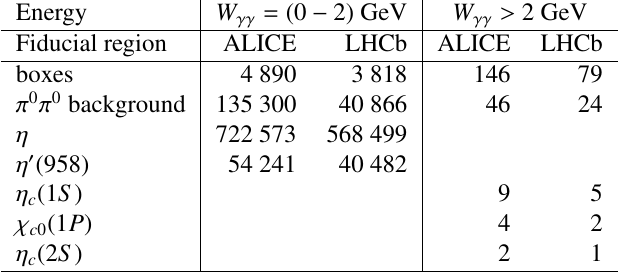
Table 2. Total nuclear cross section in